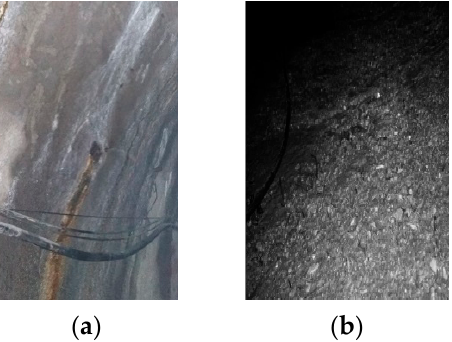
Figure 4. Photos of the degraded diversion tunnels: ( a ) the diversion tunnel of Lanzhou water source project, and ( b ) the diversion tunnel of Guangzhou energy storage power plant.